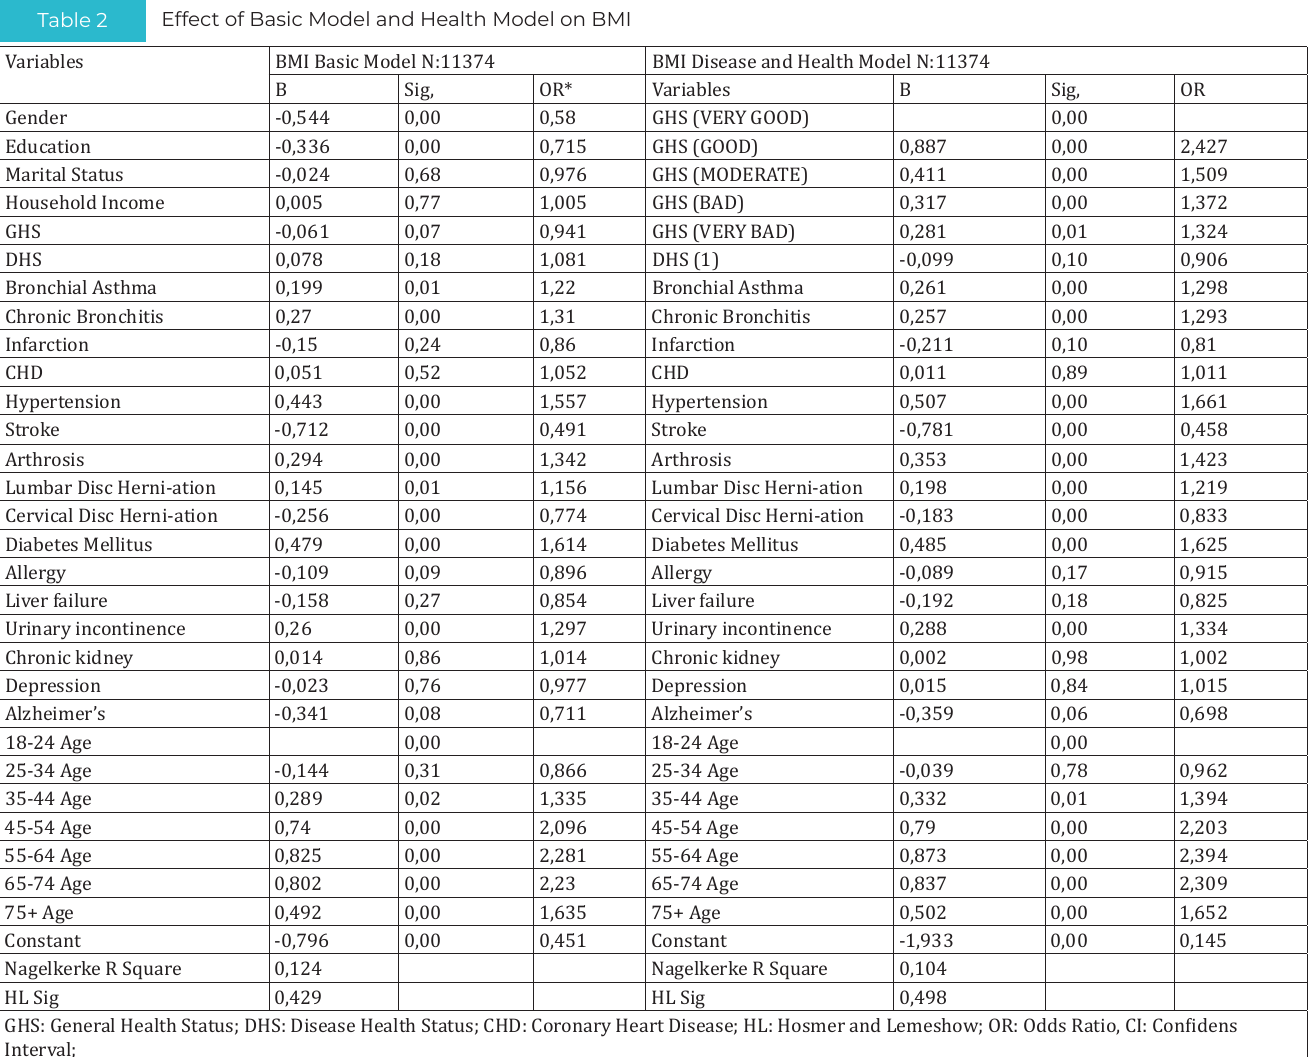
Effect of Basic Model and Health Model on